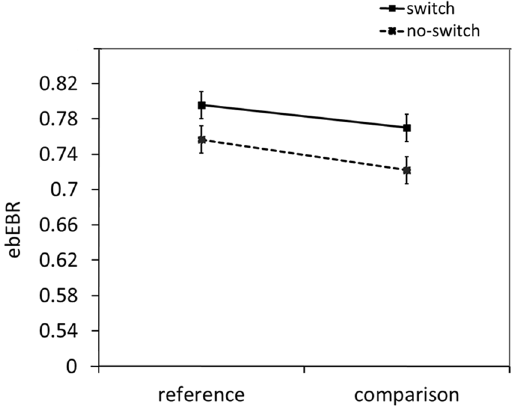
Figure 2. The ebEBR results of Experiment 1. Error bars represent 95% confidence intervals 59